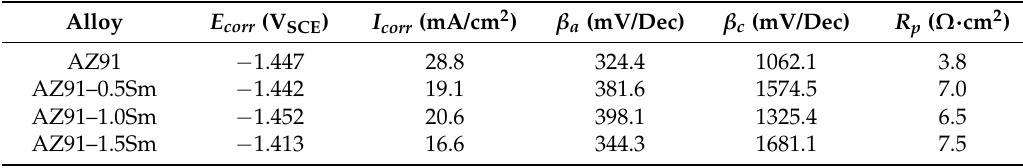
Table 2. Fitted data of the Tafel curves. E corr : corrosion potentials, I corr : corrosion current density; β a : anode Tafel slopes; β c : cathode Tafel slopes; R p : polarization